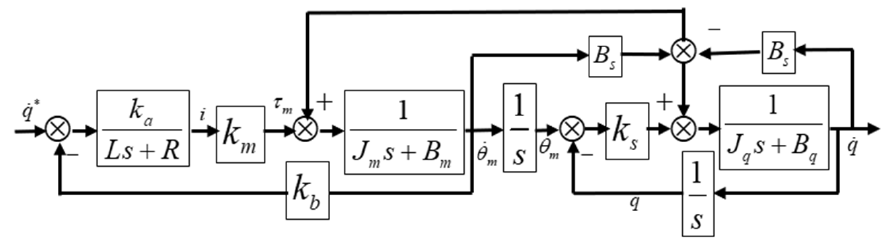
Figure 3. Structure diagram of velocity-tracking control system of the virtual flexible joint.